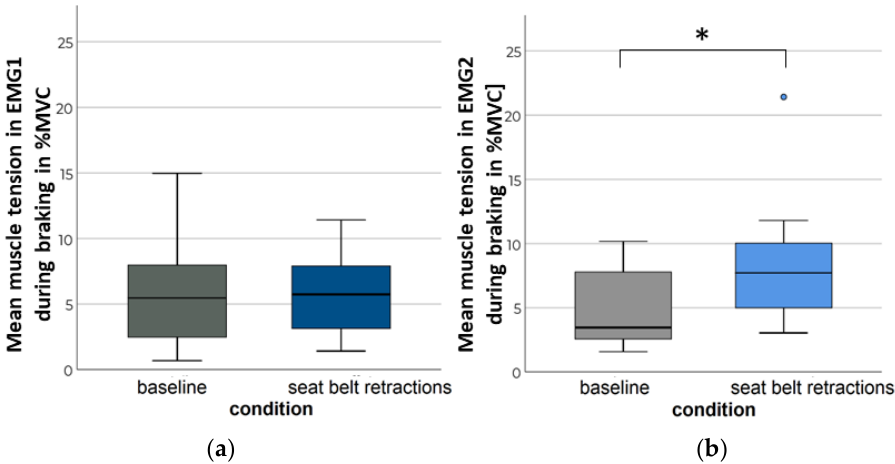
Figure 13. Distribution of mean neck muscle tension during the braking maneuvers in the baseline and with seat belt retractions: ( a ) EMG1; ( b ) EMG2. * p < 0.05.